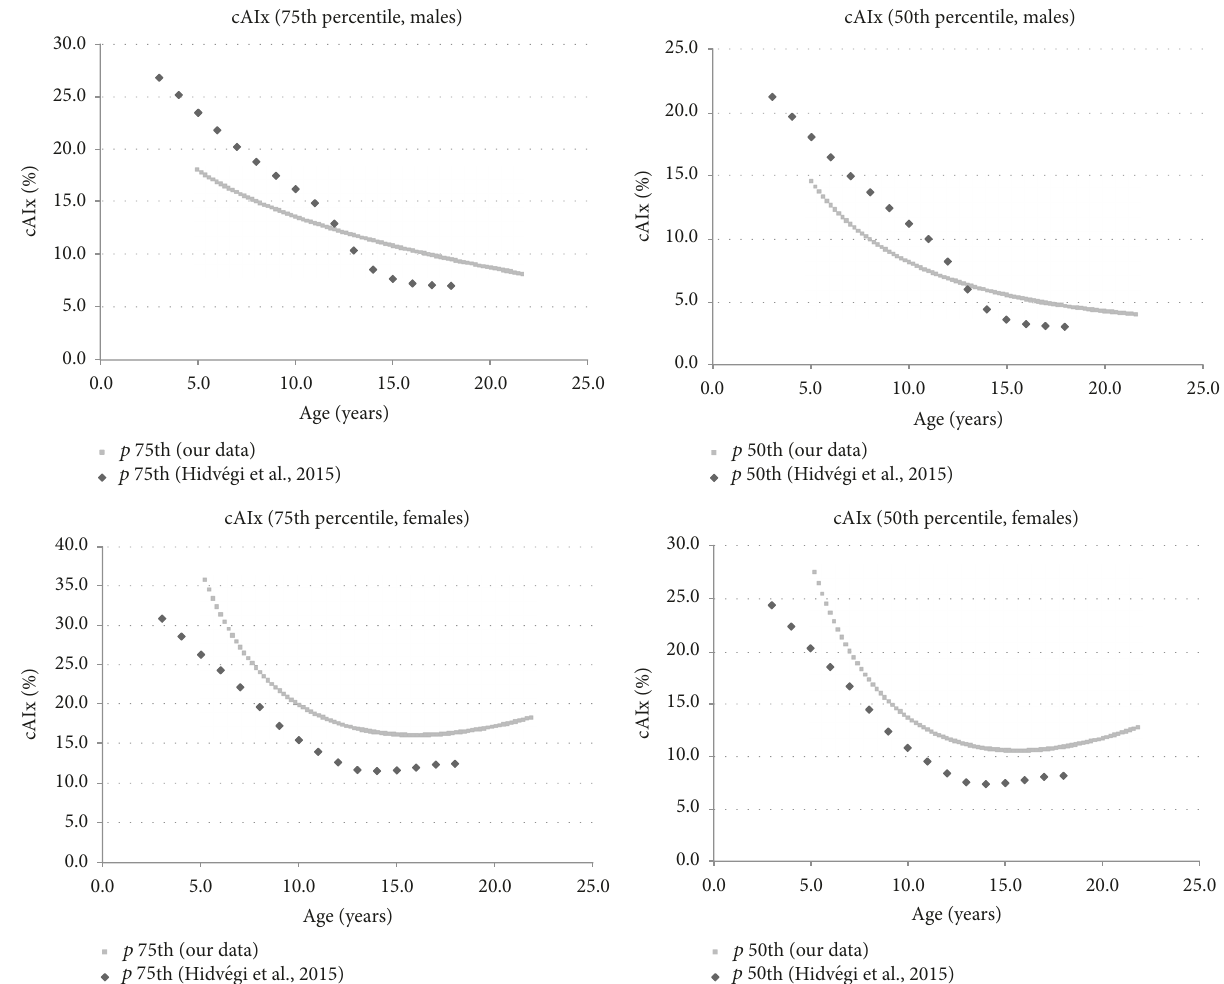
Figure 5: Age specific central (aortic) augmentation index (cAIx) percentiles 75th and 50th obtained in males and females of the Argentinean population compared with Hidv´egi et al.’s date previously reported.